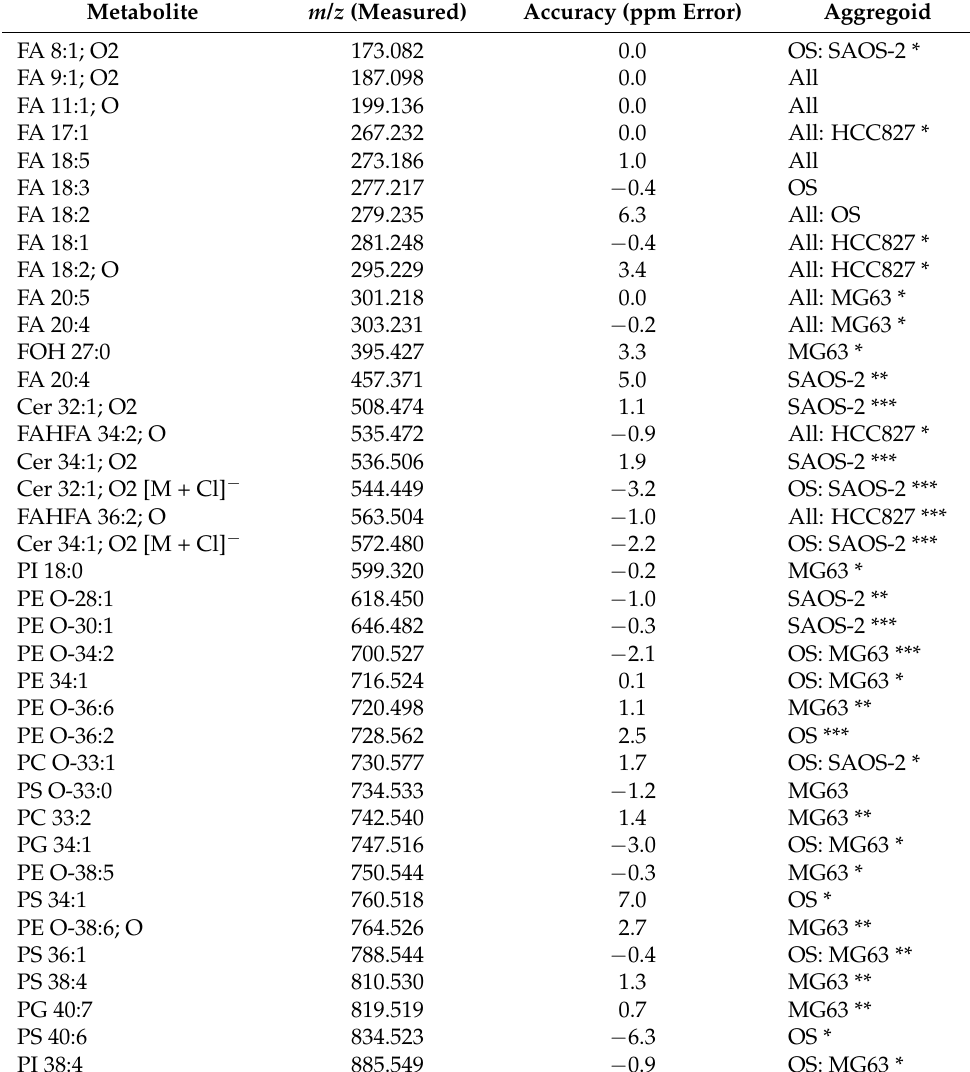
Table 1. Assignments and errors for metabolites detected in specific aggregoid models. Metabolites were filtered by removal of isotope peaks and mass accuracy (<7 ppm). Significant metabolite detection between tumour models was determined by mean intensities. Data is mean ( n =